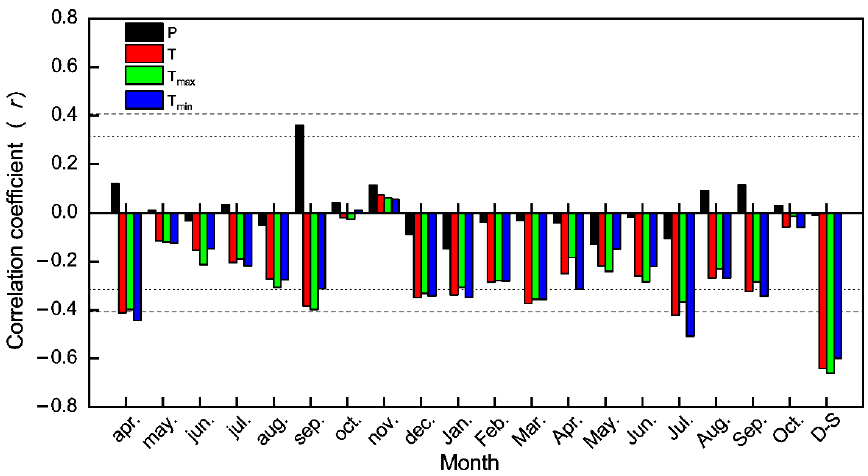
Figure 3. Correlations of tree-ring ∆ 13 C and monthly average meteorological data. Dotted/dashed